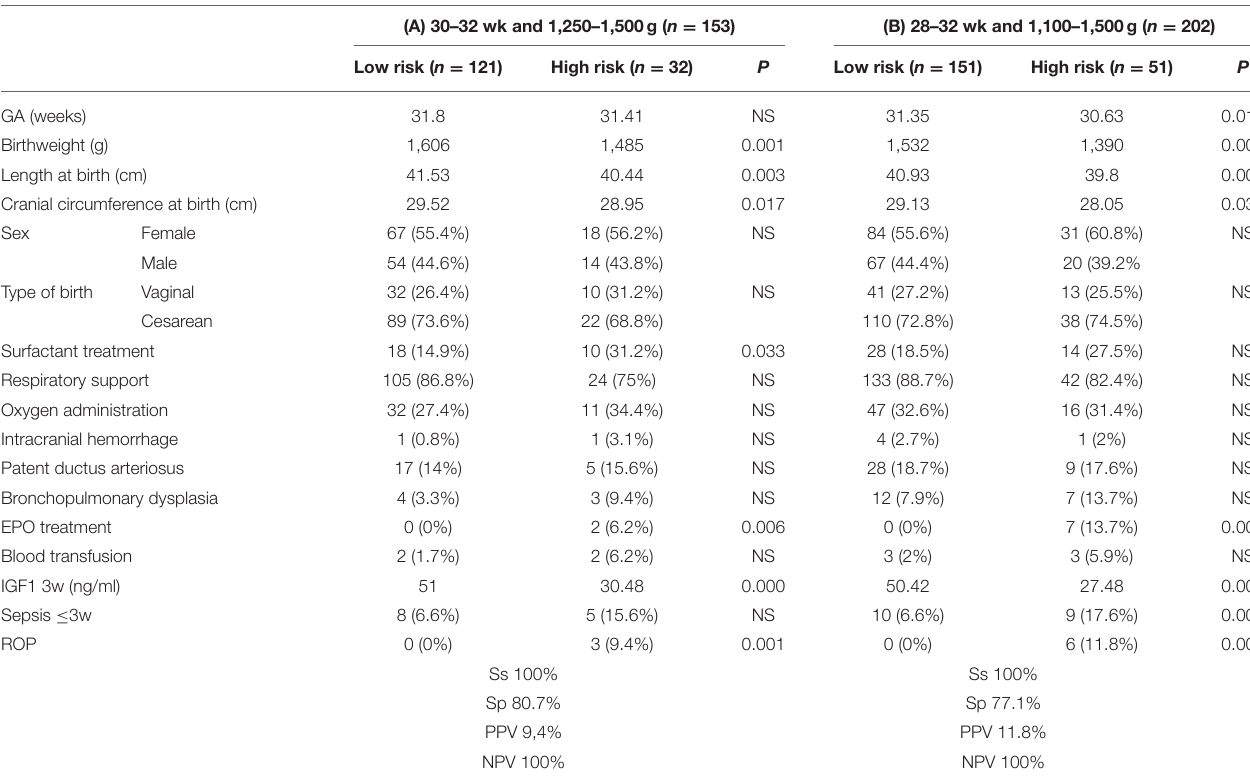
TABLE 1 | Verification of our screening method for ROP: (A) Prospective analysis (B) Theoretical retrospective analysis (after expansion of gestational age and weight